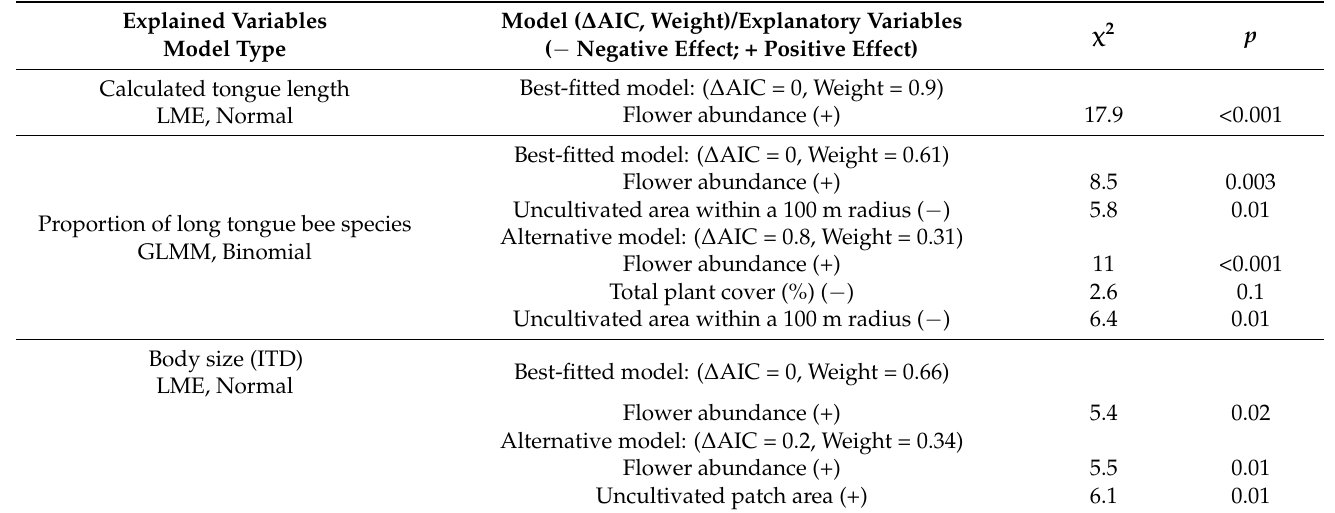
Table 4. Best-fitted LME and GLMM models ( ∆ AIC < 2) for calculated tongue length distribution, proportion of long tongue bee species, and inter-tegular distance (ITD, a proxy for body